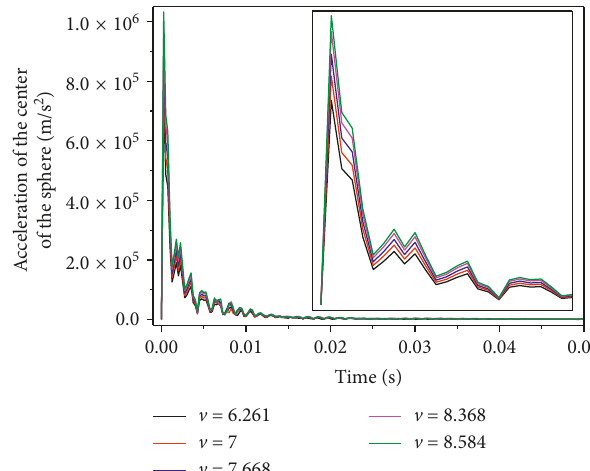
Figure 20: Acceleration of the sphere.